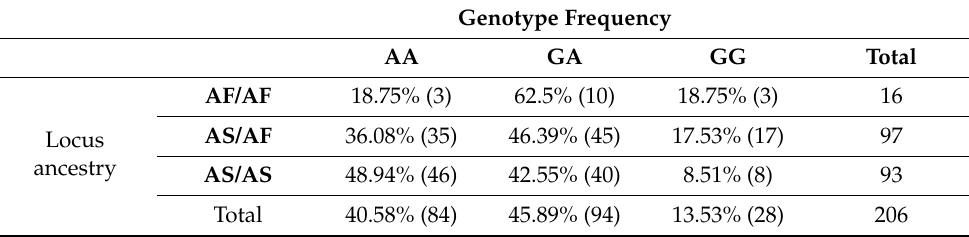
Table 2. Ability to detect beta-ionone according to (i) the participants’ genotype (column); (ii) the chromosome origins (column) (AFR-AFR: two loci with African local ancestry; AFR-EAS: one locus with African local ancestry and one with East Asian ancestry; EAS-EAS: two loci with East Asian local ancestry) (from the 235 initial participants only the 206 who have performed the threshold detection task are represented